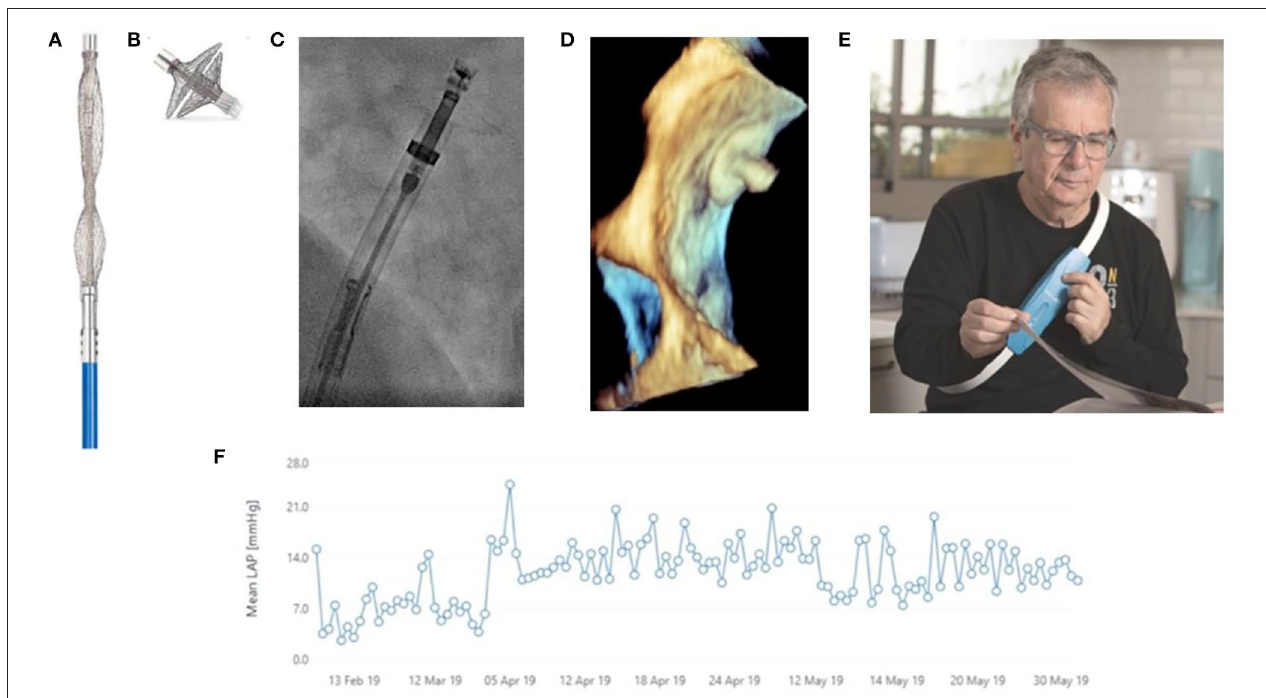
FIGURE 2 | Vectorious Medical Technologies V-LAP TM wireless sensor, a second-generation heart failure (HF) monitoring system, used for remote LAP-guided Therapy Optimization during COVID-19 era at a patient with HF. (A) The unexpanded biosensor before implantation; (B) The biosensor after ex vivo expansion; (C) The catheter with the biosensor during deployment; (D) The 3D echocardiographic check of the biosensor positioning, as part of the interatrial septum (detail image) between the right atrium and left atrium (above); (E) The external unit (the belt for the patient) continuously captures and records the left atrial pressure; (F) The continuous diagram recording of the mean left arterial pressure monitored with V-LAP TM . Alerts of the mean arterial pressure overpassing the normal values are transmitted via mobile to the cardiologist, allowing her/him to take action by optimizing the therapy. Reproduced from Di Mario et al. ( 58), with the courtesy of the